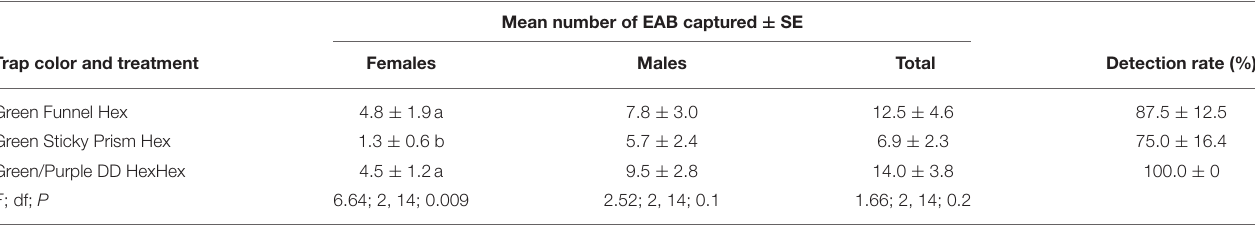
TABLE 5 | Mean number ( ± SE) of A. planipennis captured and detection rate (percentage of traps that captured at least one beetle) in Experiment 4 that compared traps of different types and colors at a Legg Park, Ingham County, Michigan with a very low emerald ash borer infestation level in